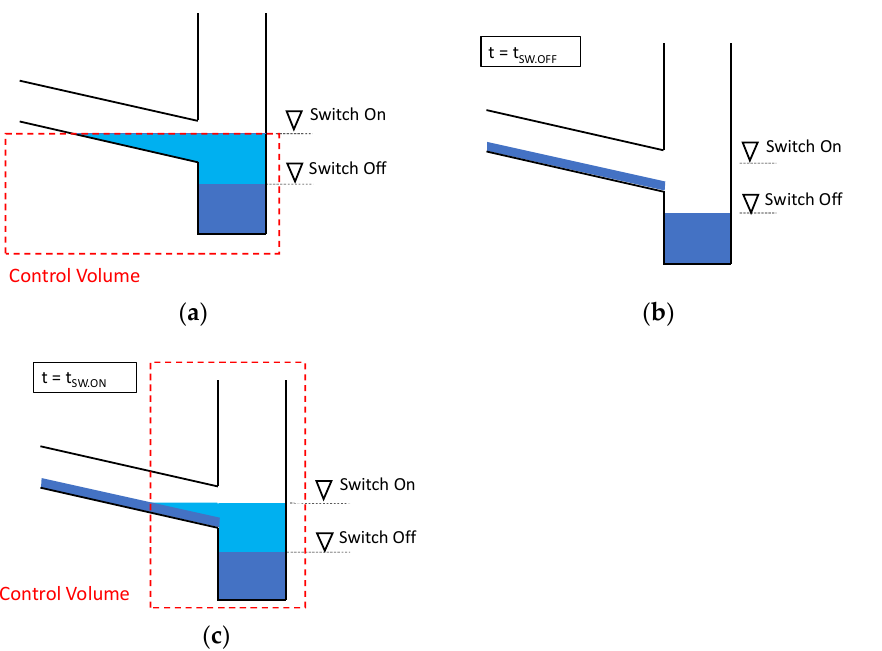
Figure A6. ( a ) Static storage-based delineation (left); ( b , c ) backwater curve-based delineation (right top and right bottom). The dark blue volumes are considered dead storage; the light blue ones are active storage.